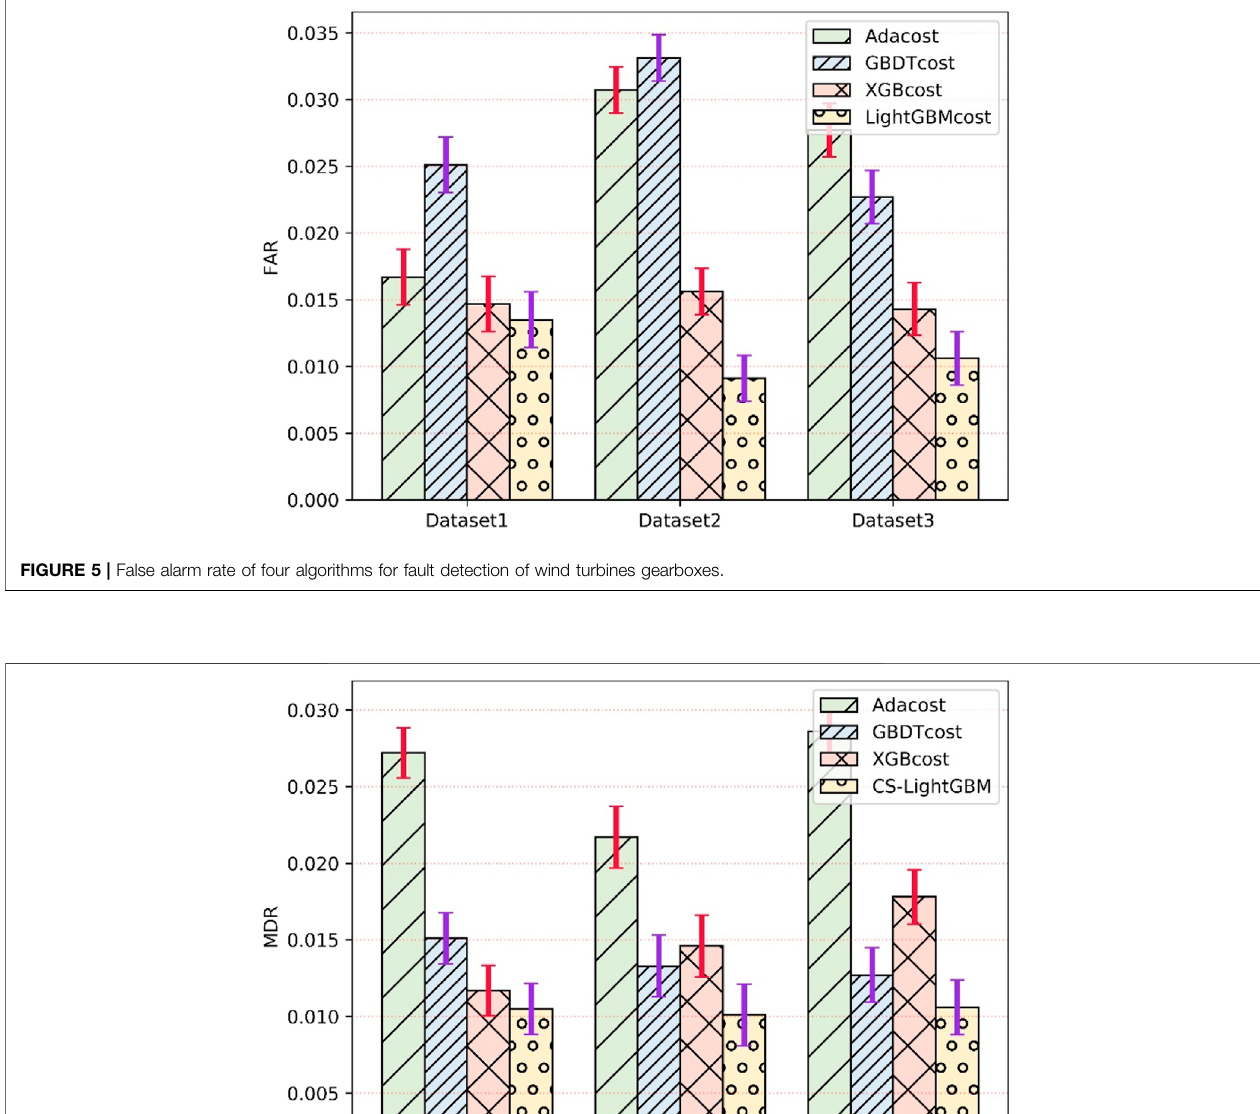
Frontiers in Energy Research |